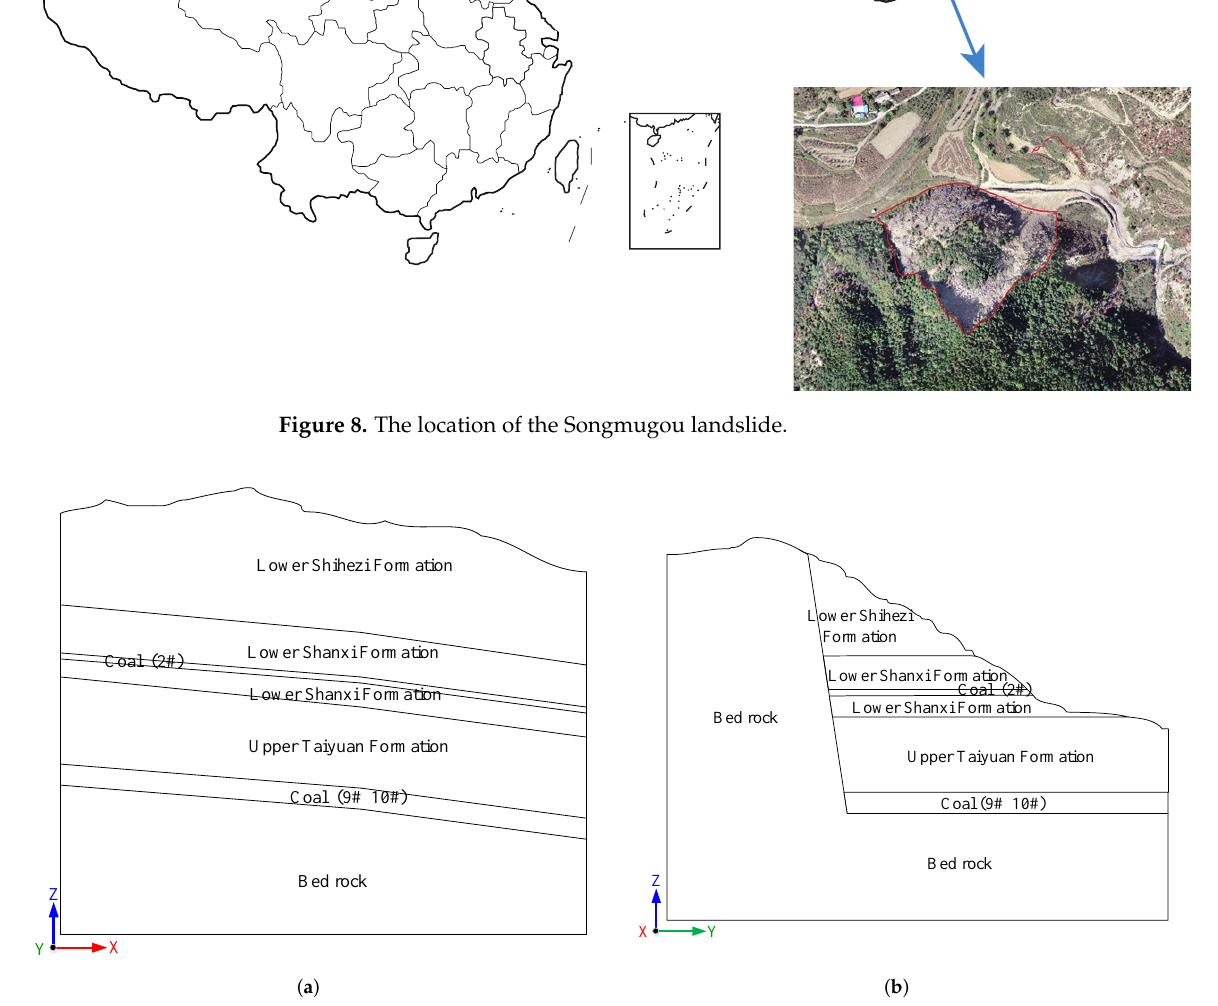
Figure 9. Geological section of the Songmugou slope. ( a ) X-direction, ( b )